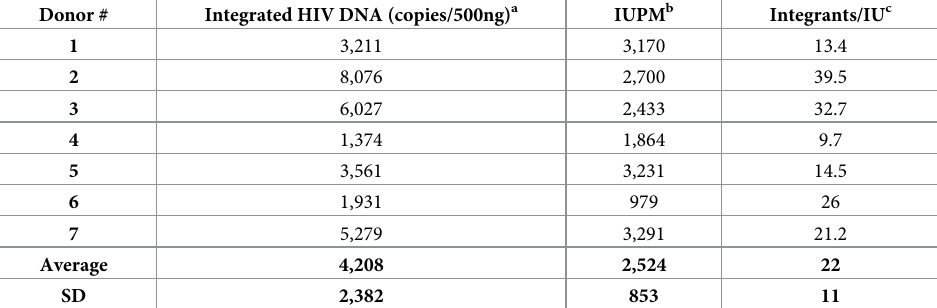
Table 4. Integrated HIV DNA, IUPM, and integrants/IU in latently infected bystander CD4 cells derived from the in vitro co-culture model. Donor